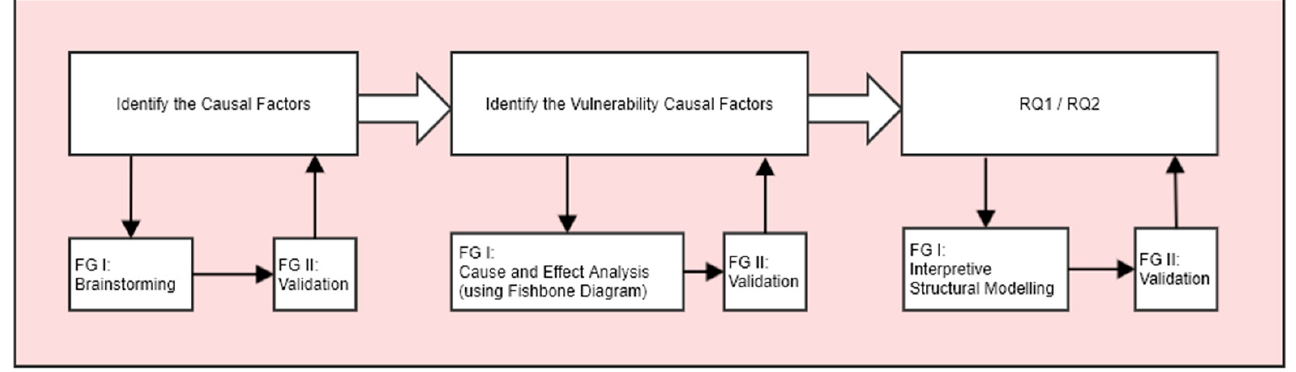
Figure 1. Use of focus groups to address the research questions.